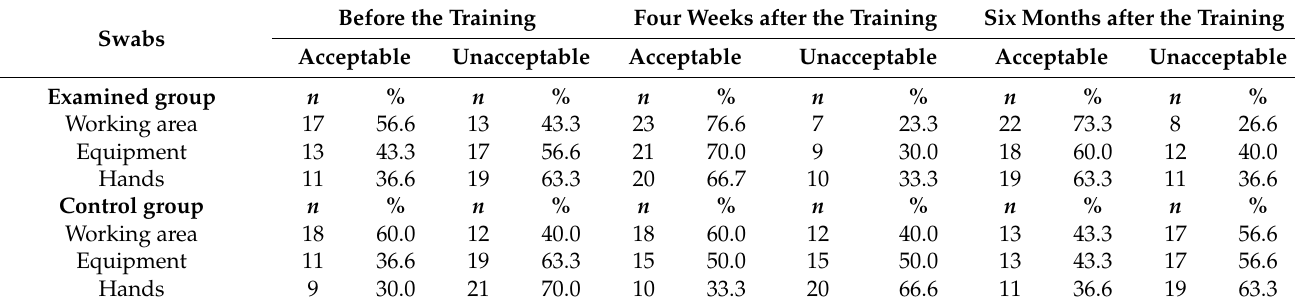
Table 6. TBC of swabs of work surfaces, equipment, and hands of food handlers for bakeries.